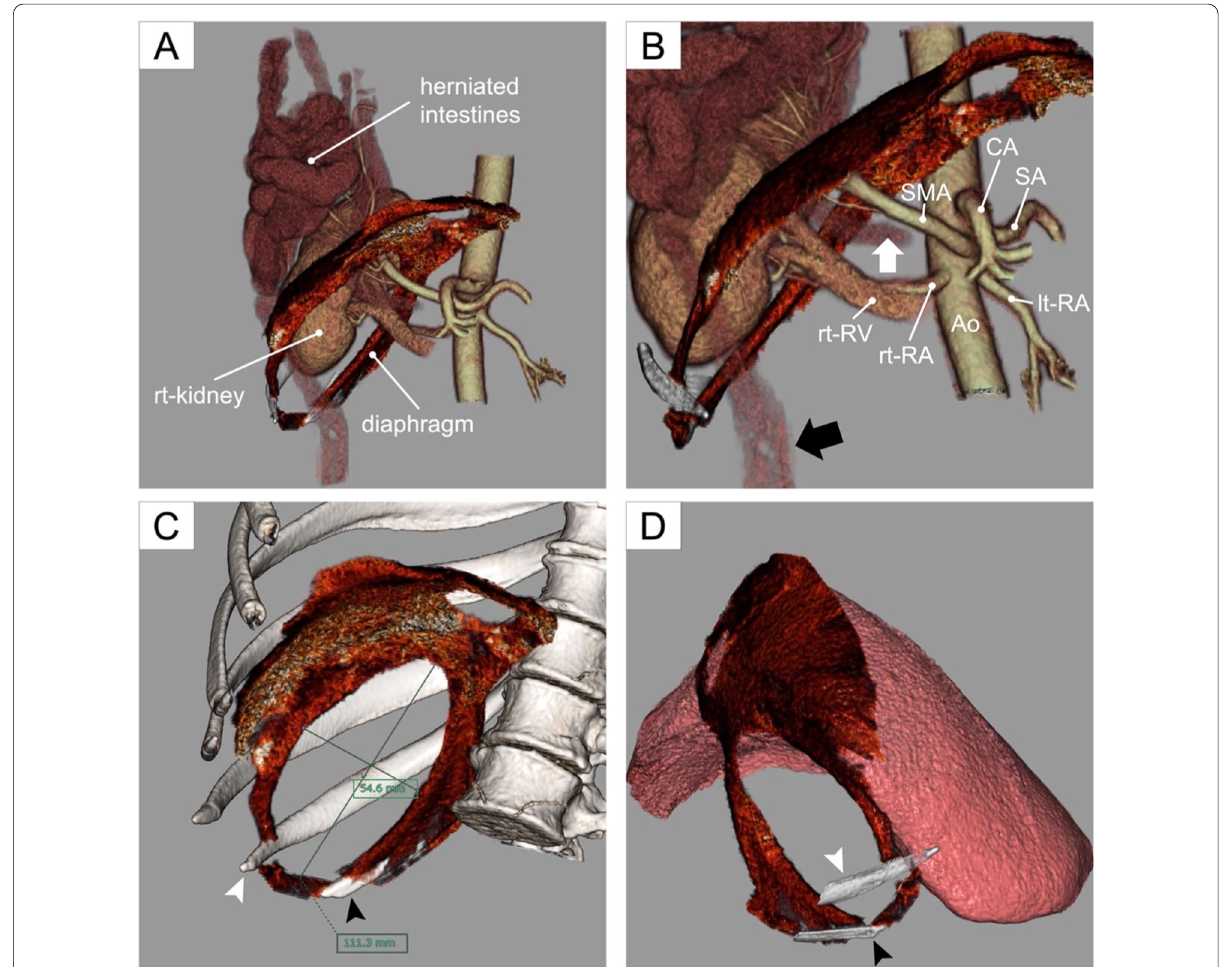
Fig. 3 Preoperative three-dimensional (3D) simulation. a Herniated intestines and the right kidney occupied the right thoracic cavity. b Portion of the alimentary tract [from the distal part of duodenum (white arrow) to the proximal part of transverse colon (black arrow)] and the main trunk of superior mesenteric artery had herniated through the diaphragmatic defect. c Oval diaphragmatic defect was present on the posterolateral portion of the diaphragm. 3D simulation precisely visualized the location and size of the defect. The eleventh rib (white arrowhead) and the twelfth rib (black arrowhead) with intercostal muscles constituted the posterolateral part of the defect. d Right lobe of the liver was flattened, thus leaving the large diaphragmatic defect uncovered. Ao aorta, CA celiac artery, lt-RA left renal artery, rt-kidney right kidney, rt-RA right renal artery, rt-RV right renal vein, SA splenic artery, SMA superior mesenteric